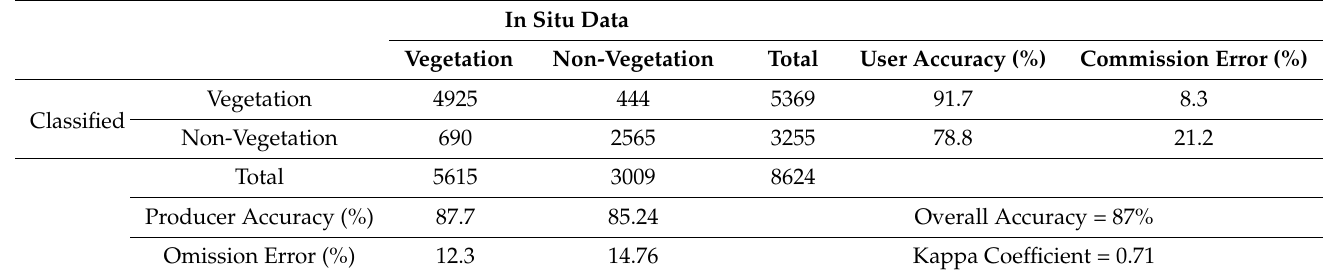
Table 2. Confusion matrix of the classification based on the Category 1